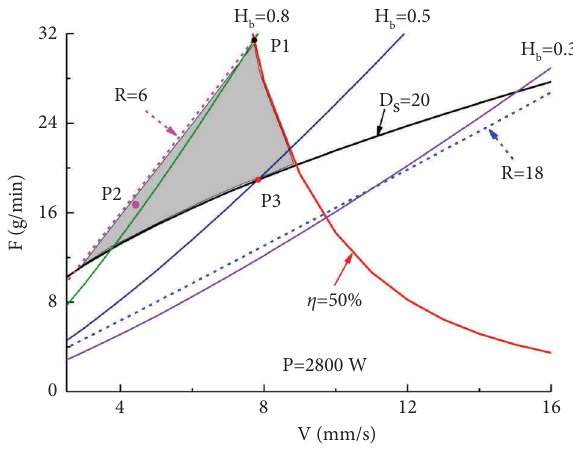
Figure 12: Process map for optimization of deposition speed and powder efciency at P � 2800